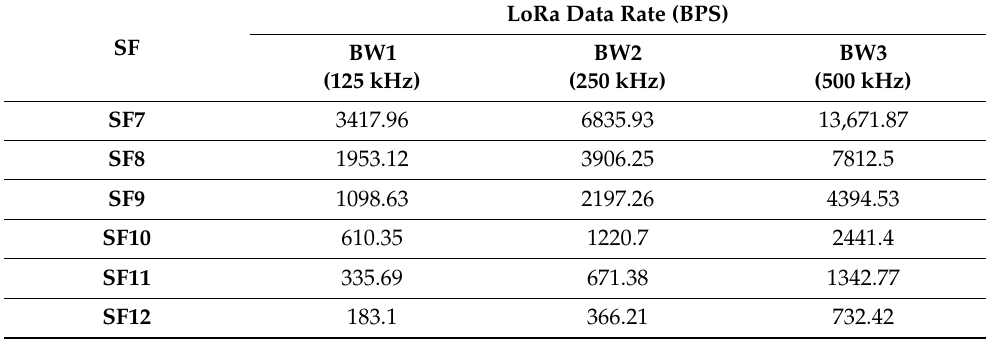
Table 8. LoRa data rate/bit rate at CR4.